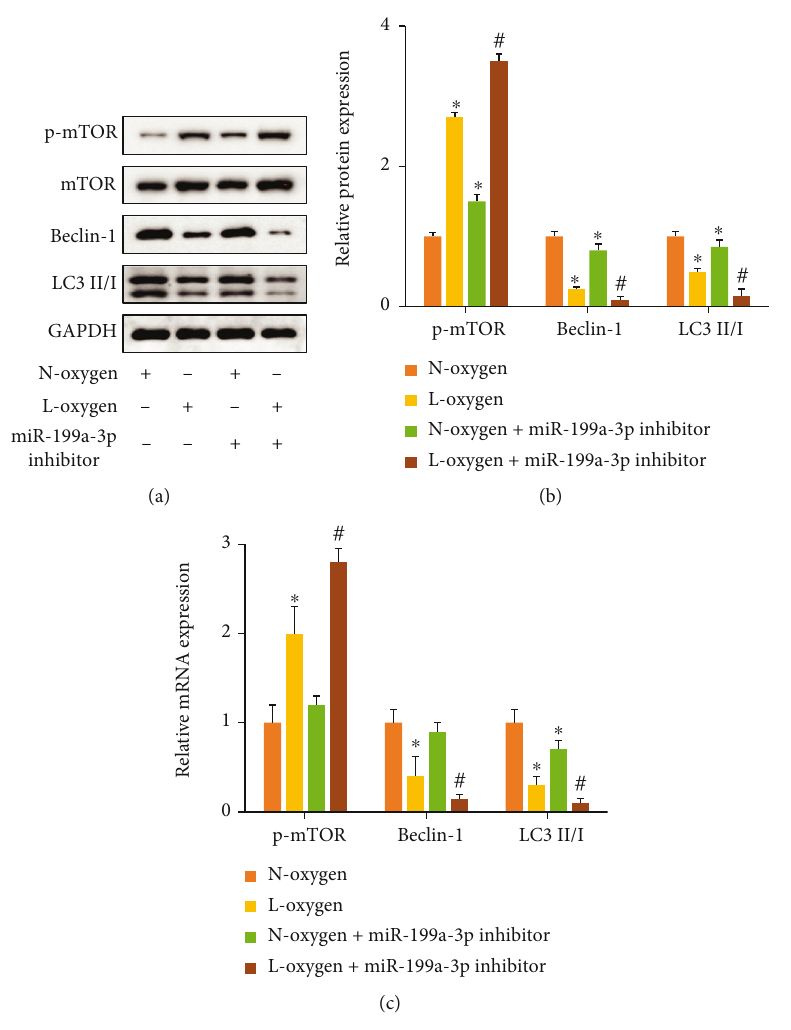
Figure 2: miR-199a-3p suppressor elevated the concentration of mTOR and restrained autophagy. (a) The protein expression levels were evaluated via western blotting. (b) The protein expression levels were quanti fi ed. (c) The mRNA expression levels were evaluated via qRT-PCR. ∗ P < 0 : 05 compared to group N-oxygen. # P < 0 : 05 compared to group L-oxygen.